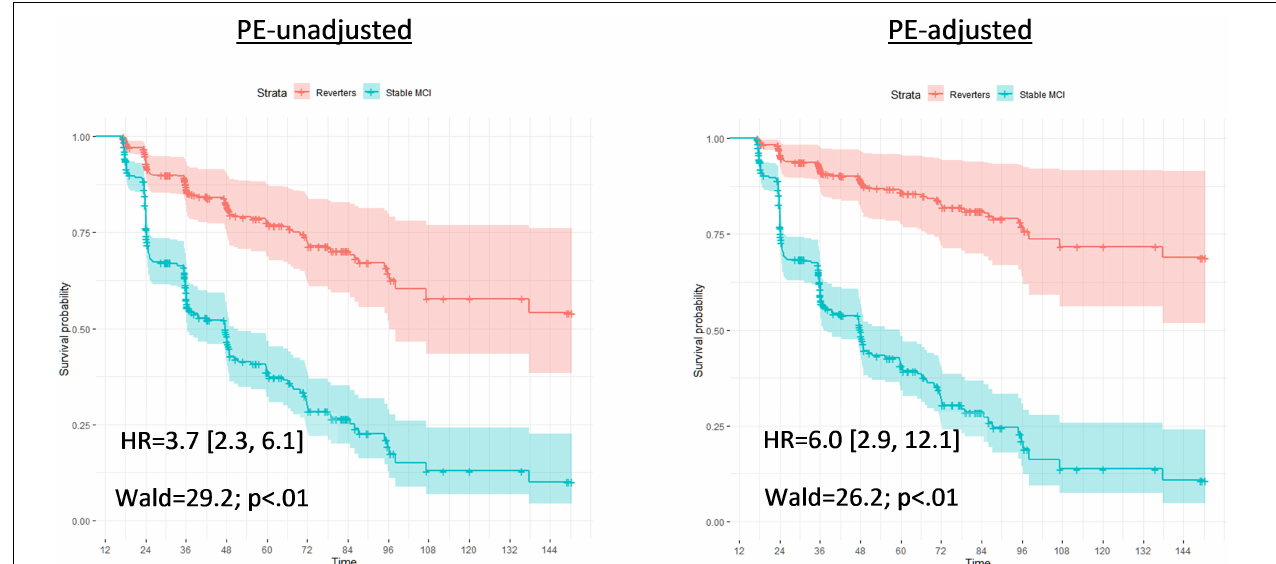
FIGURE 1 | Full Cox proportional models for time until first dementia diagnosis by PE-unadjusted and PE-adjusted 12-month diagnoses. Cox proportional hazard models compared progression to dementia between those who were classified with mild cognitive impairment at follow-up (Stable MCI) and those who reverted to cognitively normal (Reverters). Models used classifications (Stable MCI vs. Reverter) as the independent variable of interest; months from baseline until first dementia diagnosis as the dependent variable; and all variable data (16 – months from baseline). Covariates were age and education, fixed at the average level within the sample (age: 73.1 years; education: 16.4 years). The left graph bases diagnoses on the PE-unadjusted 12-month data; the right graph uses diagnoses based on the PE-adjusted 12-month data. Each model presents a hazard ratio (HR; [CI]) that indicates how much more likely the Stable MCI group was to convert to dementia compared to the Reverters. Wald tests and likelihood-ratio tests (LRT) are also included with associated p -values to denote the significance of the HR. The Y -axis of each model provides the survival probability and the X -axis of each model provides the time frame until dementia